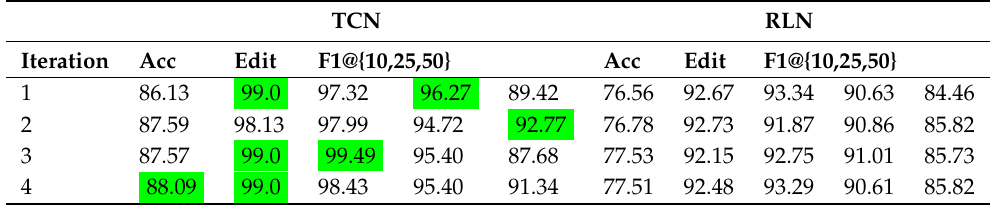
Table 3. RL-SSI in the JIGSAWS